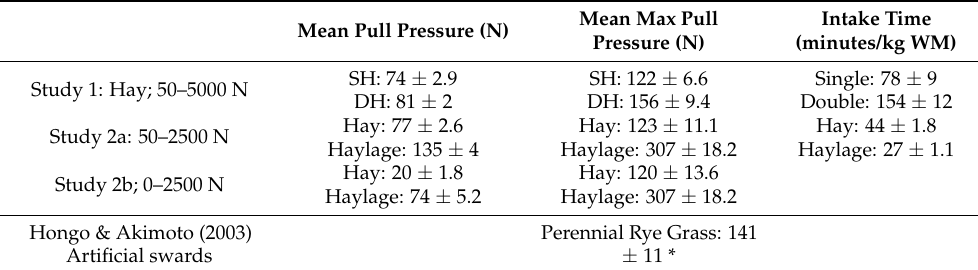
Table 3. Comparison of results Study 1 (Single- SH versus double—DH layered haynets) and Study 2—all single haynets for hay only using (a) Results when removing data <50 N (to align with gauge data from Study 1 for better comparison) and (b) full Results as presented, and one further bite pressure study by Hongo & Akimoto [9] (N=Newtons).